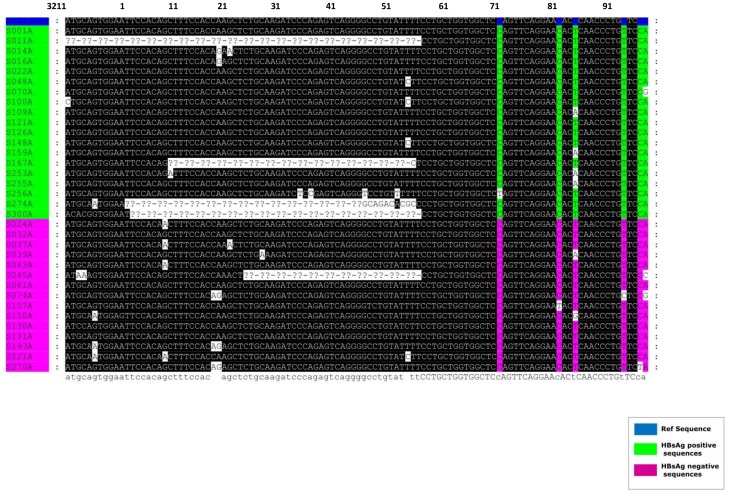
Deletions detected in the pre-S1/pre-S2 region of the HBV belonging to subgenotype A1 and isolated from HIV co-infected southern Africans.Position 1 corresponds to the EcoRI cleavage site of the HBV genome.